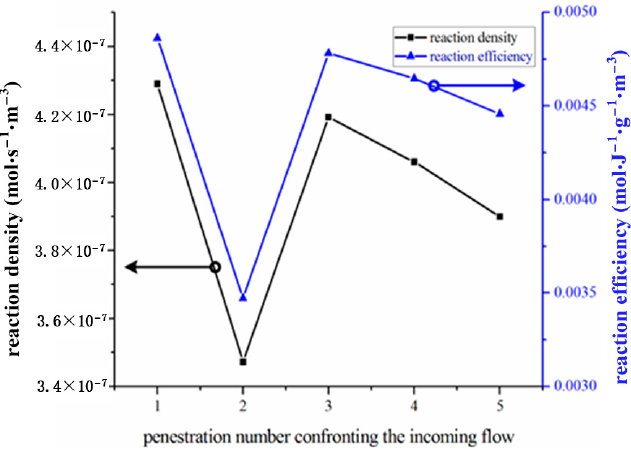
Figure 12. The variation of reaction density and efficiency with penetration number of gas channels.